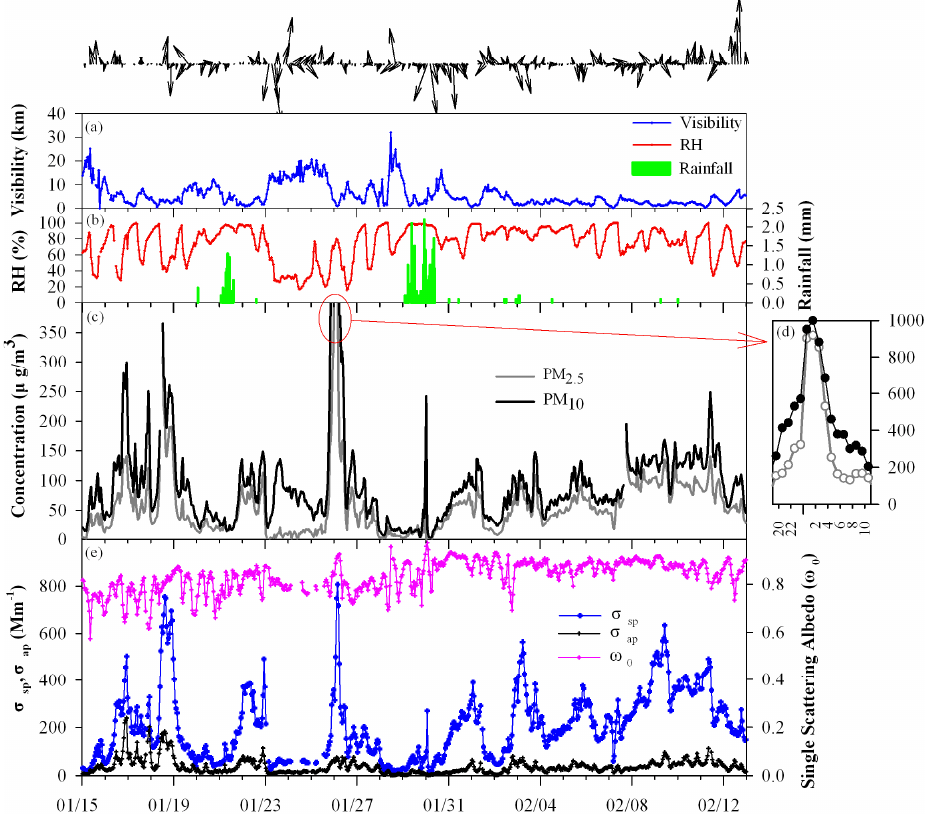
Fig. 1. Time series of meteorological conditions and various aerosol parameters with time resolution of 1h from 15 January to 12 February 2009 in Shanghai. (a) wind speed/direction and visibility (b) relatively humidity (RH) and rainfall (c) PM 2 . 5 and PM 10 mass concentration during the whole study period (d) PM 2 . 5 and PM 10 mass concentration on the Chinese Lunar New Year’s Eve (25 January) and the Chinese Lunar New Year’s Day (26 January) (e) aerosol scattering coefficient ( σ sp ), absorption coefficient ( σ ap ) and single scattering albedo ( ω 0 ).